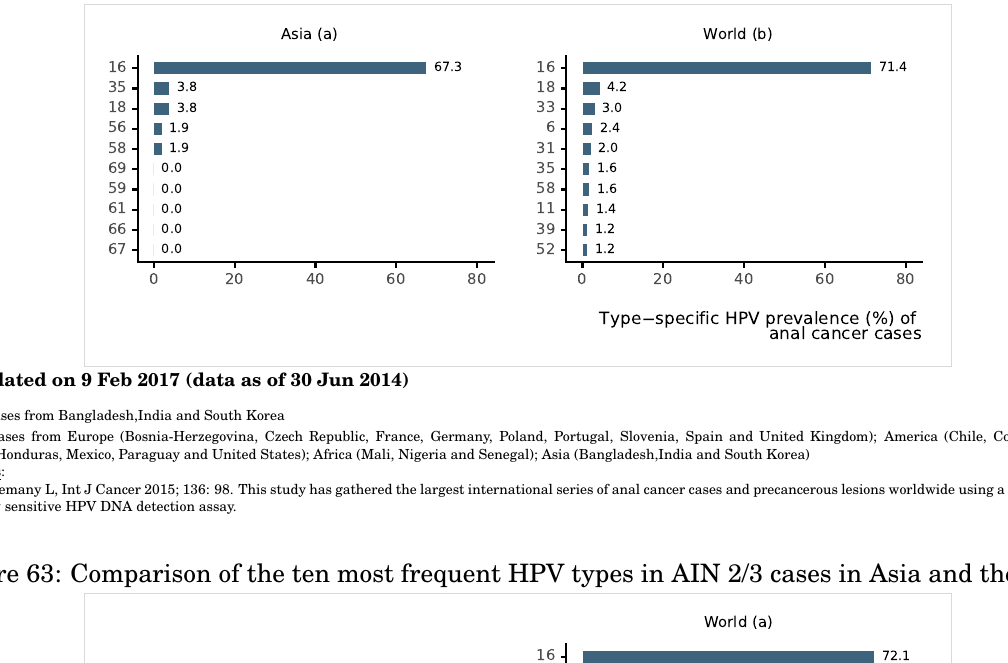
Figure 62: Comparison of the ten most frequent HPV types in anal cancer cases in Asia and the World